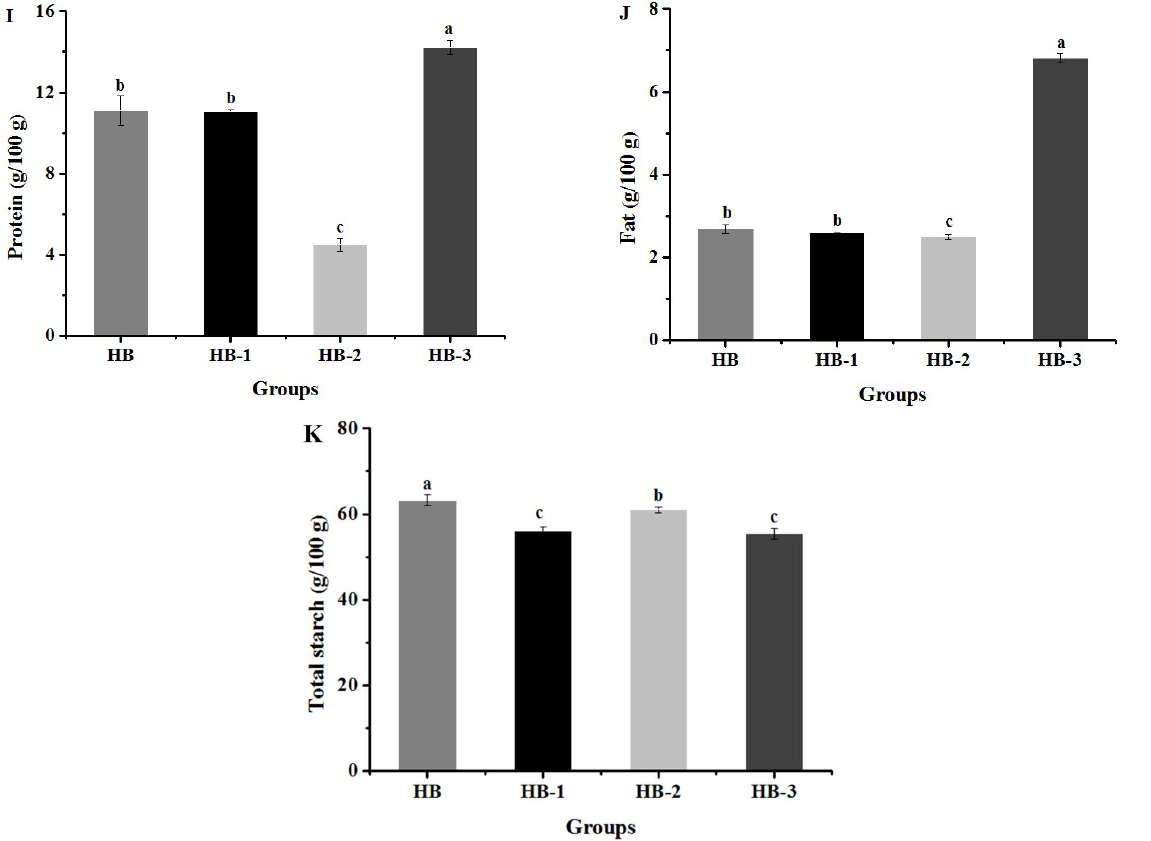
Figure 2. Composition levels of HB (Highland barley), HB-1 (microwave fluidized Highland barley), HB-2 (extruded and puffed Highland barley), and HB-3 (ultrafine pulverized Highland barley). β - glucan ( A ); Total polysaccharides ( B ); Dietary fibers ( C ); Total anthocyanins ( D ); Free phenols ( E ); Bound phenols ( F ); Moisture ( G ); Ash ( H ); Protein ( I ); Fat ( J ); Total starch ( K ). All data are shown as the mean ± SD. Values with different letters are signifi-cantly different at p < 0.05.